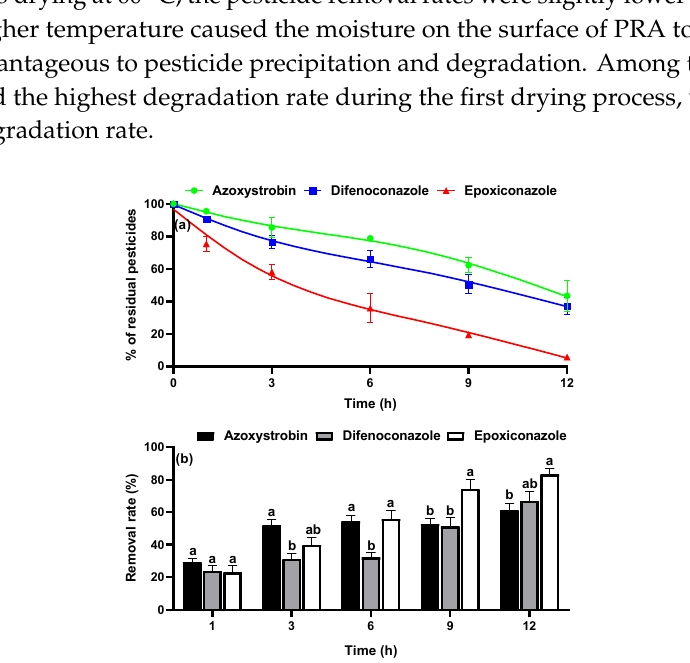
Figure 4. Changes in the concentrations of azoxystrobin and difenoconazole in PRA during soaking and moistening.